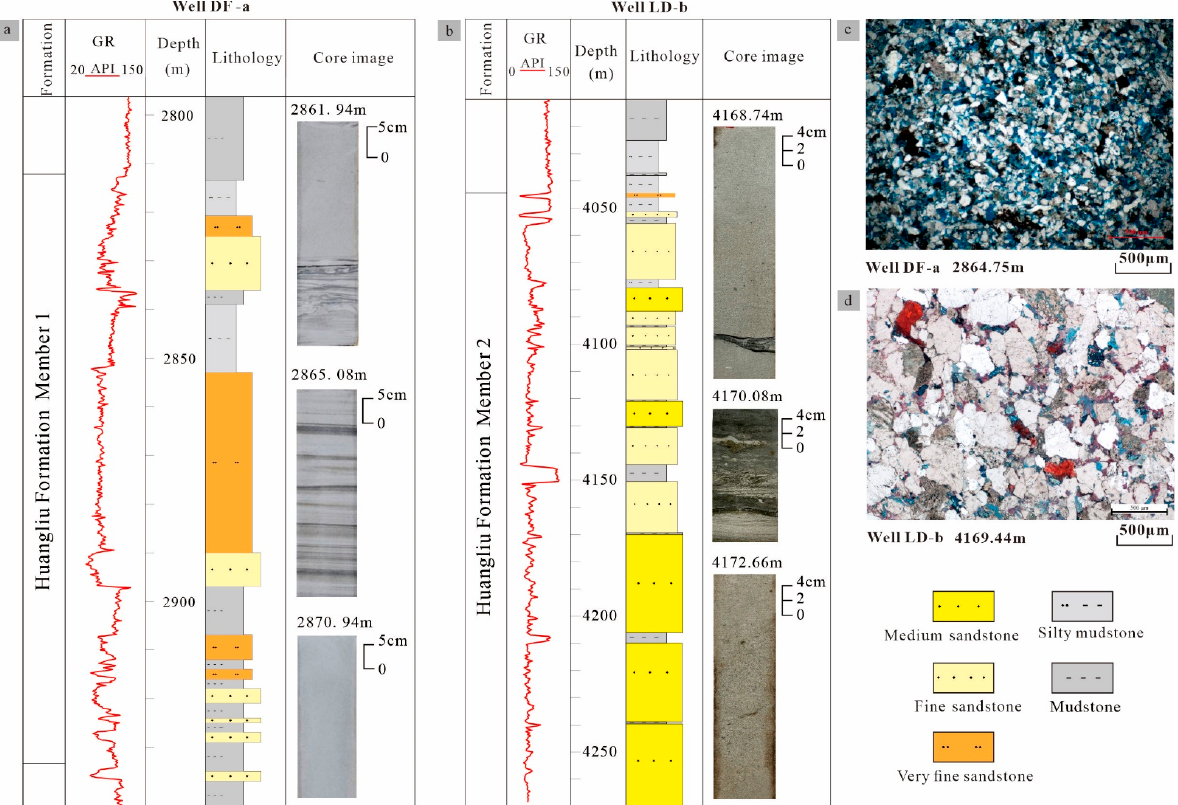
Figure 3. Well logging curves, lithology interpretation, core images and thin section observations: ( a ) Well DF-a in the Huangliu Formation upper member. ( b ) Well LD-b in the Huangliu Formation lower member. ( c ) Well DF-a sample thin section observation at 2864.75 m. ( d ) Well LD-b sample thin section observation at 4169.44 m.